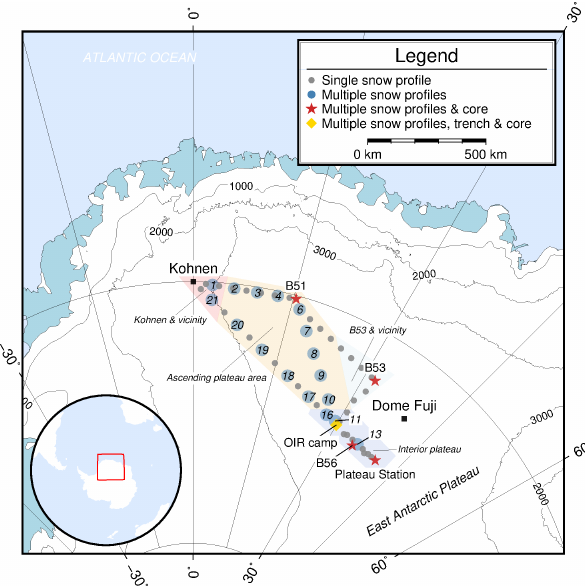
Figure 1. Overview map of the traverse route and sampling loca- tions; inset shows location in Antarctica. Contour lines are given in 1000ma.s.l. intervals. The first sampling position with multiple lin- ers after Kohnen Station is named location 1. Following the traverse route, B51 is also called location 5, OIR camp location 12, Plateau Station location 14, B56 location 15 and B53 location 22 (see Ta- ble 2). The 200m firn cores were drilled at locations indicated with a red star. Subregions defined in Sect. 2.5 are colored differently (Kohnen and vicinity: purple; ascending plateau area: orange; B53 and vicinity: light blue; interior plateau: